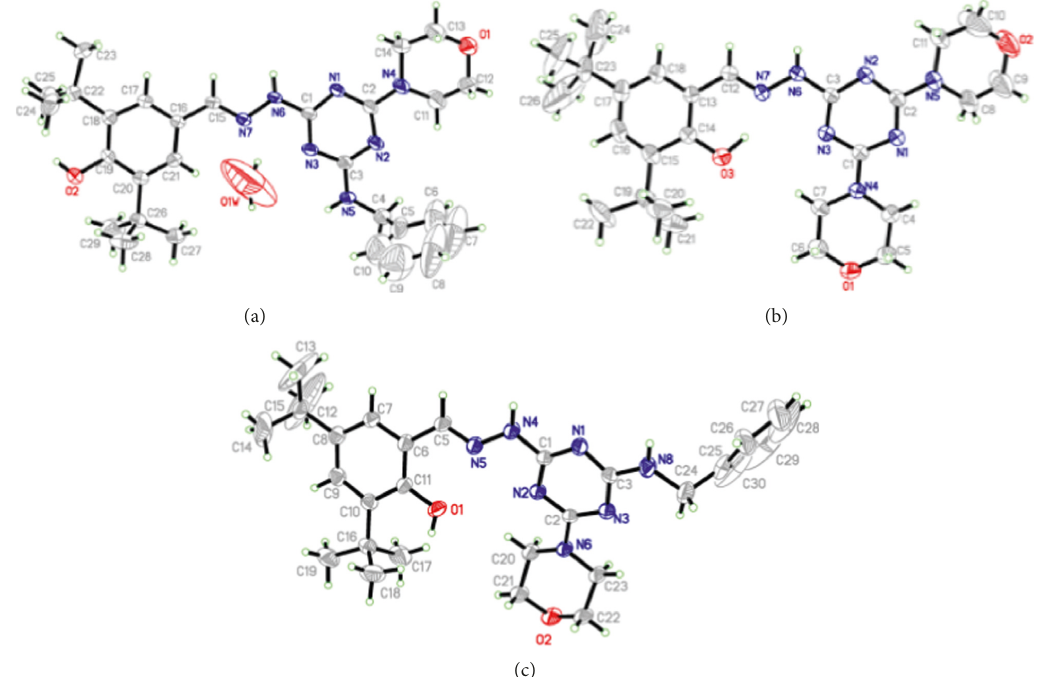
Figure 2: ORTEP diagram of the titled compounds 4f (a), 5b (b), and 5f (c). Displacement ellipsoids are plotted at the 40% probability level for non-H